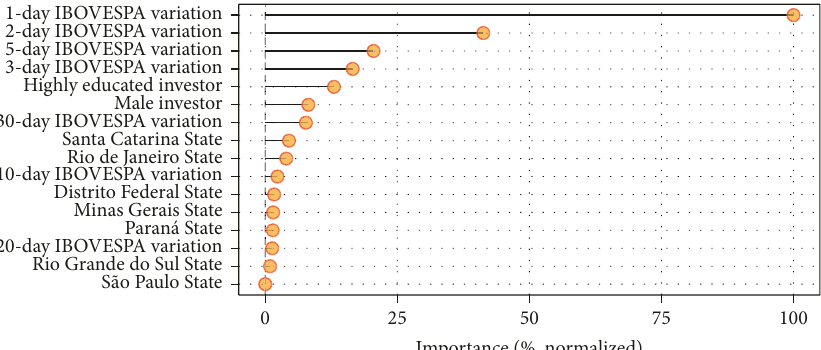
Figure 5: Feature selection results using an elastic net procedure with L most important attribute (“1-day IBOVESPA